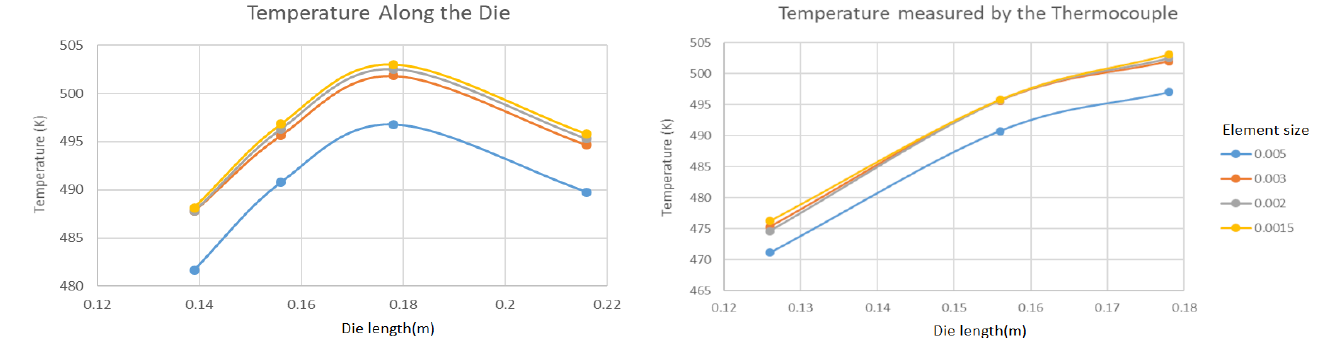
Figure 7. Temperature measured along the die and in the thermocouple slots in the numerical analysis. This simulation used all of the resistors, but only the rightmost water channel at 288 K (15 ◦ C), providing a more suitable temperature gradient for the cooling of the filament. The die considered additional water channels. Although they were not necessary for the current application, they were included to allow a more precise temperature control when using the mold with different material